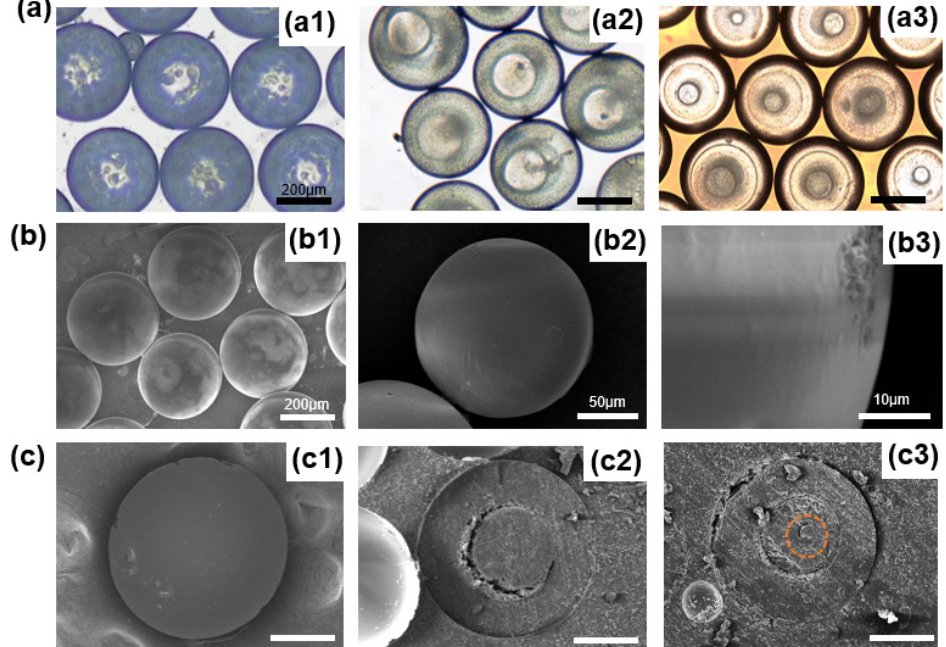
Figure 5. ( a ) Optical microscopic images of microspheres with different numbers of layers: ( a1 ) One layer, ( a2 ) Two layers, ( a3 ) Three layers. The scale bar is 200 µm. ( b ) Scanning electron microscope images of microspheres prepared at one flow rate ratio. (b1) SEM image showing good monodispersity and sphericity of microspheres; (b2) Magnified SEM image of the microsphere; (b3) SEM image showing the solid, smooth, and dense surface of the microsphere. ( c ) Scanning electron microscope images of different number-layered microspheres cut open: ( c1 ) One layer, ( c2 ) Two layers, ( c3 ) Three layers. The scale bar is 100 µm.